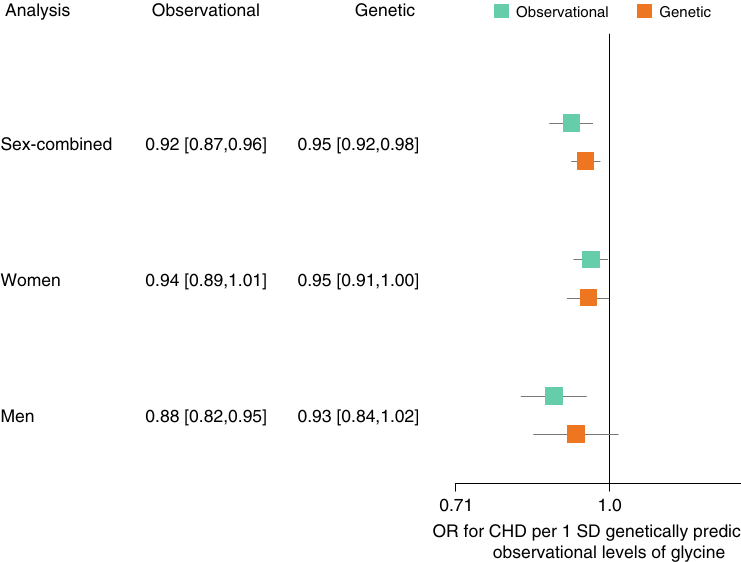
Fig. 4 Forest plot of the odds ratios ± 95% con fi dence intervals for coronary heart disease per standard deviation observationally or genetically predicted higher levels of glycine. Genetic estimates are based on 88,800 CHD cases and 485,266 controls. Sex-speci fi c genetic analyses included 9,852 female and 21,994 male CHD cases and 202,124 female and 164,944 male controls. For the sex-speci fi c analyses, sex-speci fi c standard deviations for glycine were used, which were 0.321 and 0.195 (arbitrary units) for women and men in EPIC-Norfolk, respectively. Observational analyses are based on 11,147 participants (4989 men and 6158 women), of which 2053 (1223 men and 830 women) were incident CHD